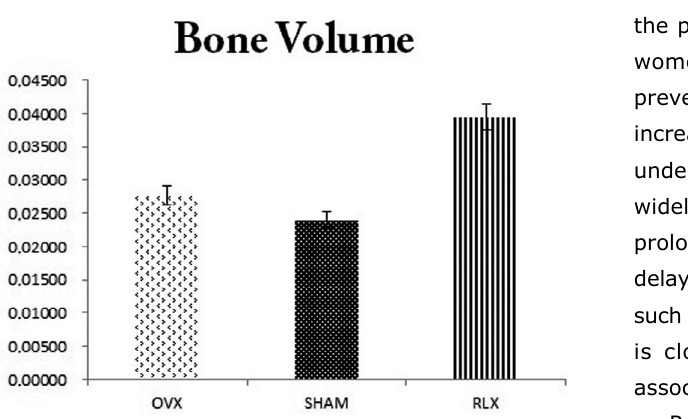
Figure 7- Chart with mean and standard deviation showing that RLX group tended to have higher bone volume values, followed by the OVX and SHAM groups